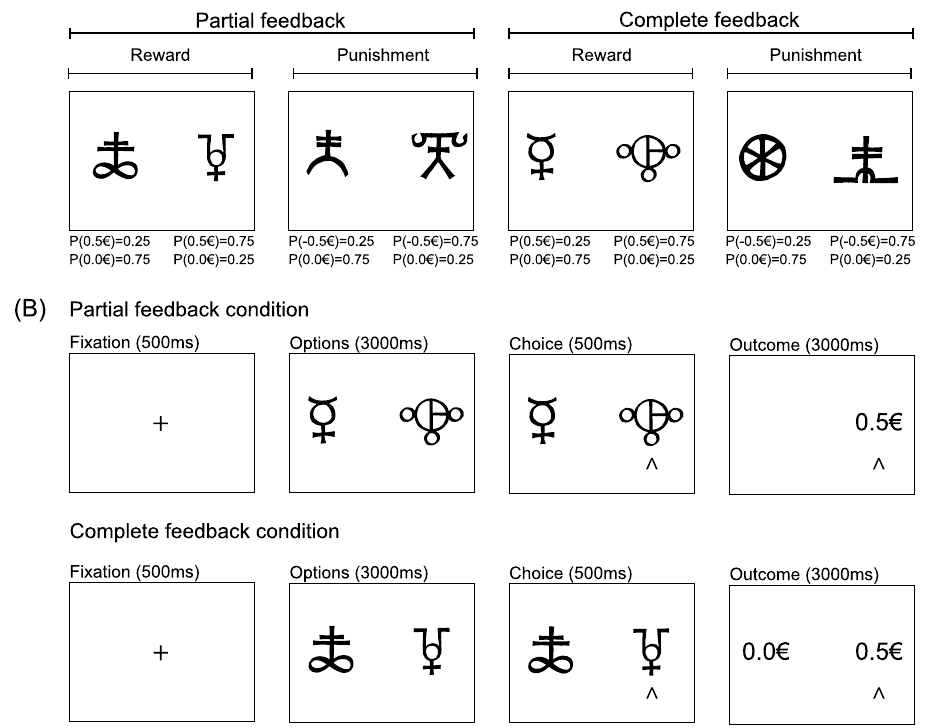
Figure 1. Task. ( A ) Task contingencies and factorial design. The attribution of symbols to each condition was randomized across subjects. ( B ) Typical trials. A novel trial started after a fixation screen (500 ms). Subjects were required to select between the two options by pressing one of the corresponding two buttons with their left or right index fingers to select the leftmost or the rightmost option, respectively, within a 3000- ms time window. After the choice window, a red pointer appeared below the selected option for 500 ms. At the end of the trial, the options disappeared and the selected option was replaced by the outcome (“ + 0.5 €”, “0.0 €” or “ − 0.5 €”) for 3000 ms. In the complete information context, the outcome corresponding to the unchosen option (counterfactual) was also